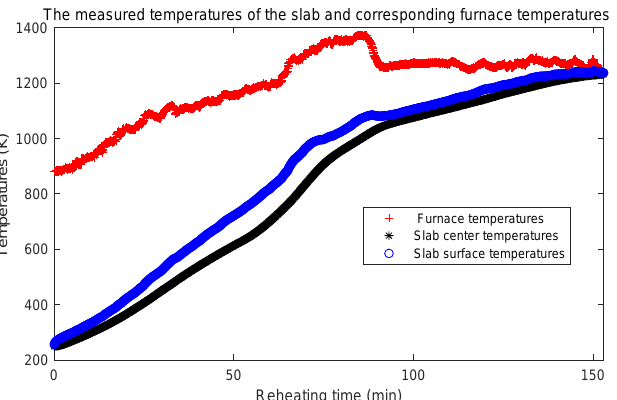
Figure 12. The measured center and surface temperature of the slab and corresponding furnace